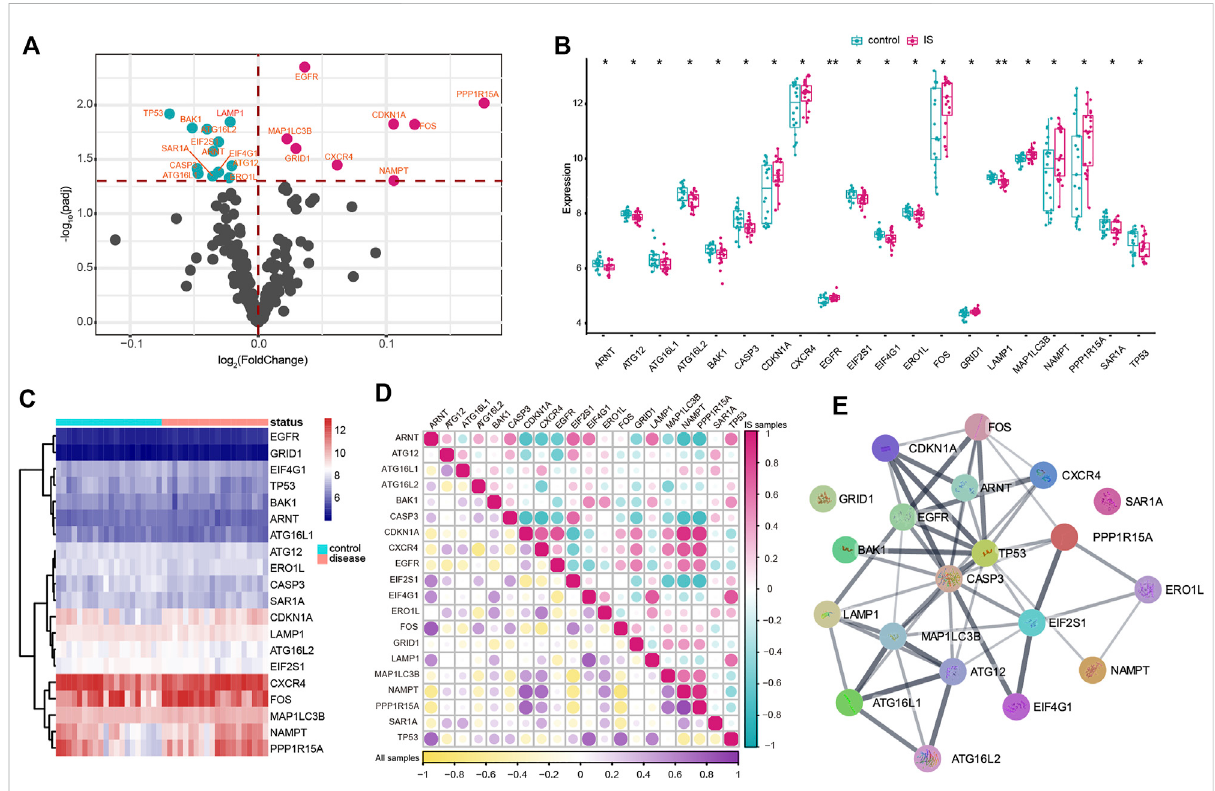
FIGURE 1 Expression landscape of autophagy genes in IS. (A) Volcano plots of differentially expressed autophagy genes. Purple circles represented upregulated genes, and green circles represented downregulated genes. (B,C) Box plot and heatmap plot showed the expression status of 20 dysregulated autophagy genes between IS and healthy samples. (D) Correlation analysis among 20signi fi cantly dysregulated autophagygenes in all samples and IS samples. (E) Interactions among multiple proteins encoded by dysregulated autophagy